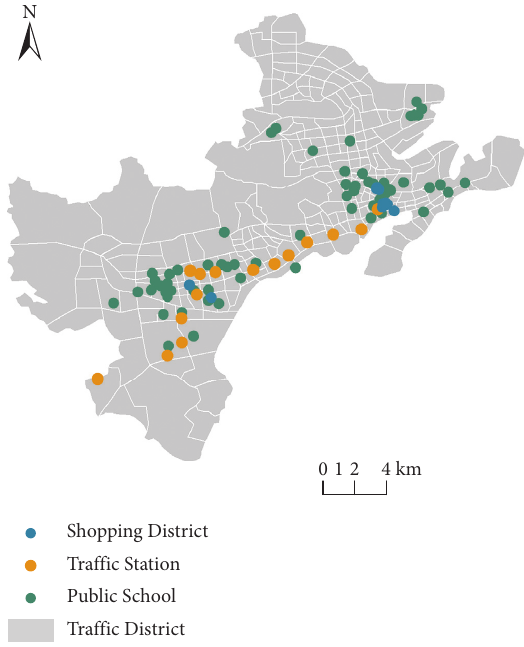
Figure 2: A distribution map of densely populated points and traffic districts.